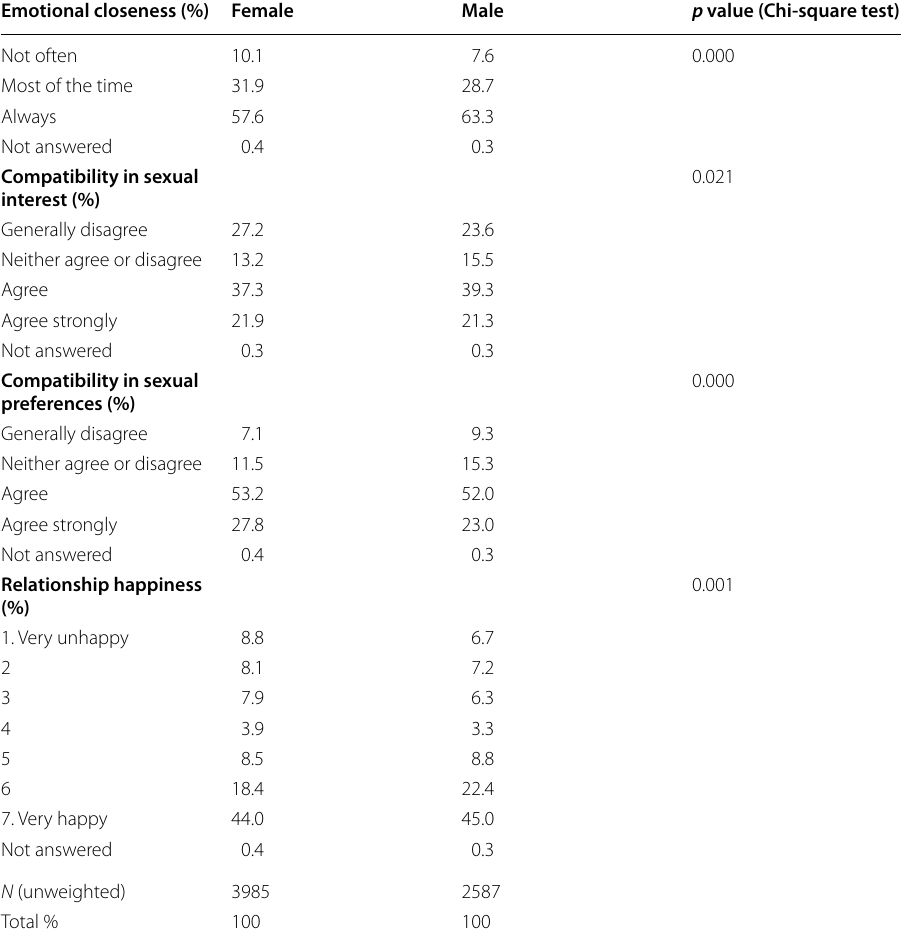
Table 2 Distribution of dependent variables by